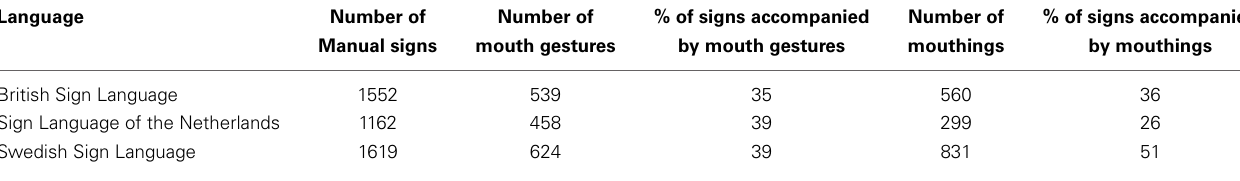
Table 1 | Comparison of hand/mouth actions in three sign